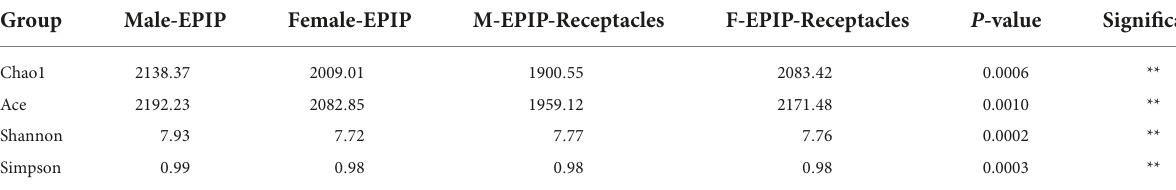
TABLE 1 Diversity indices of epiphytic bacterial communities on male and female S. thunbergii and their receptacles (Kruskal–Wallis test). Group Male-EPIP Female-EPIP